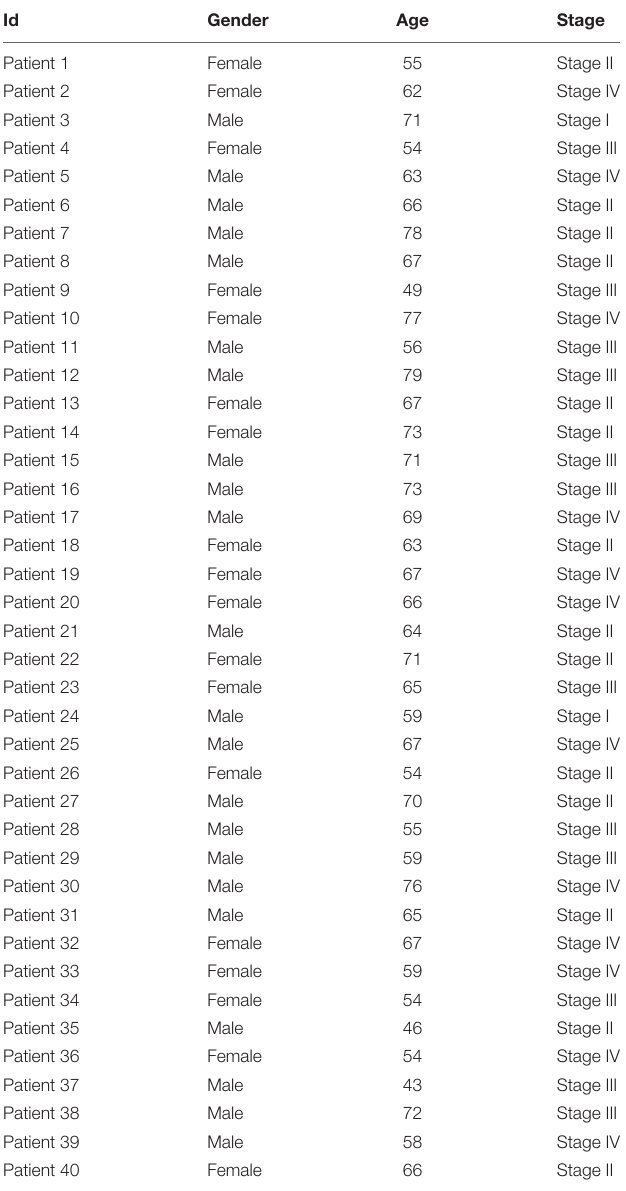
TABLE 1 | Clinical characteristics of the studied